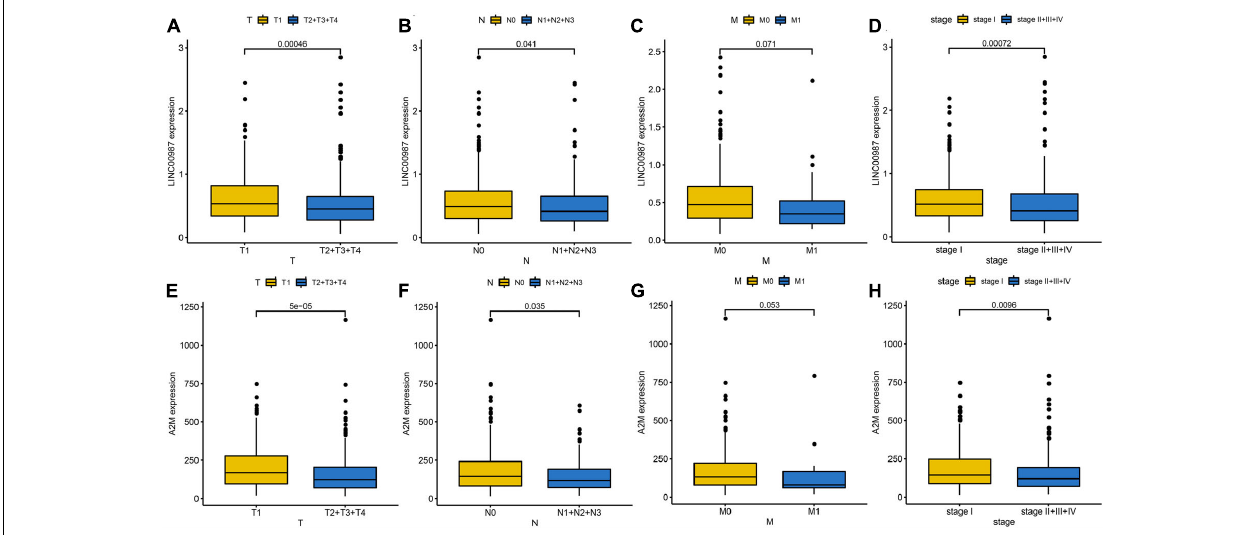
FIGURE 2 | Identification of clinical characteristics of the two immune-related genes in the LUAD TCGA cohort. Differential expression of LINC00987 (A–D) and A2M (E–H) among the T (tumor), N (node), M (metastasis), and stage, evaluated using the Wilcoxon